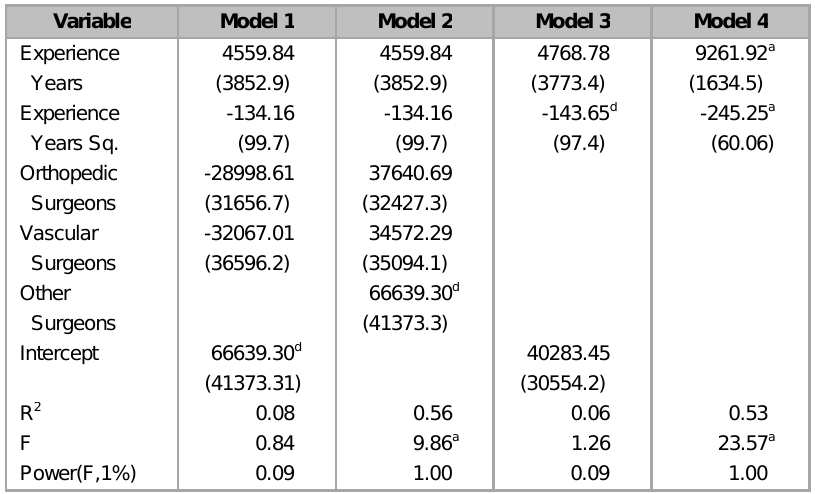
Linear regression of